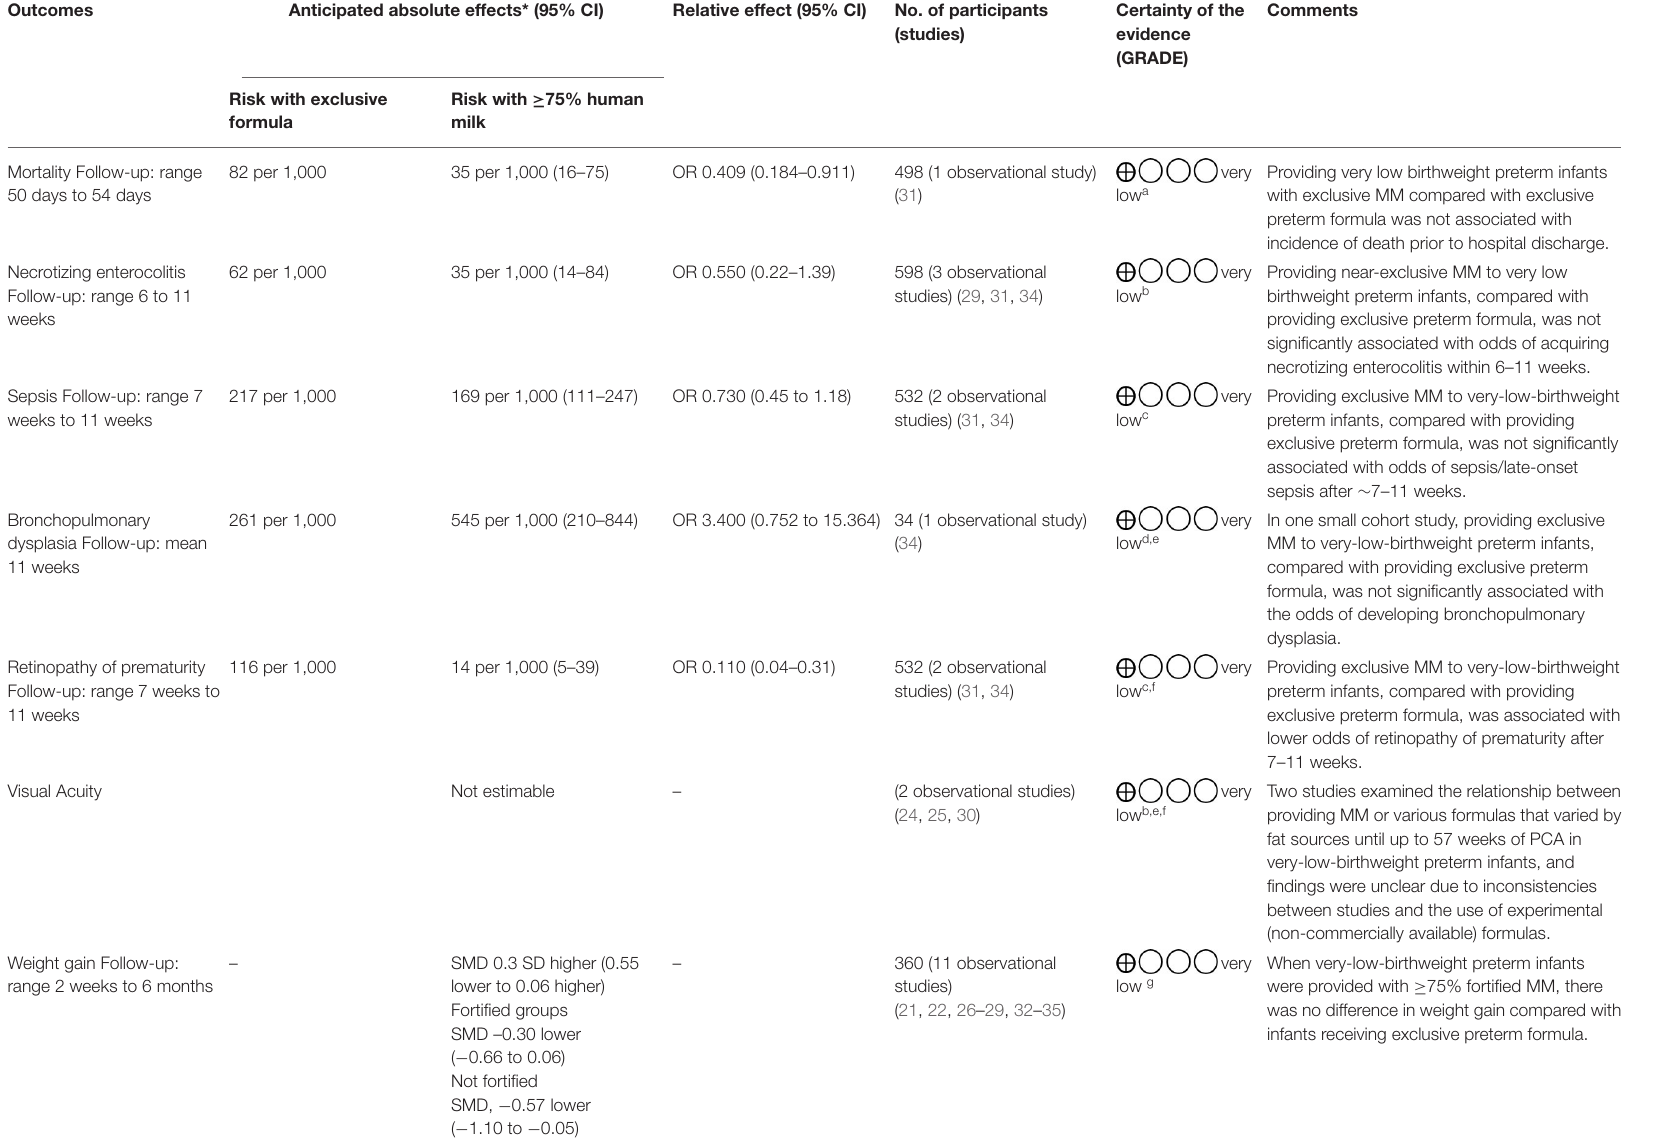
TABLE 3 | Summary of findings